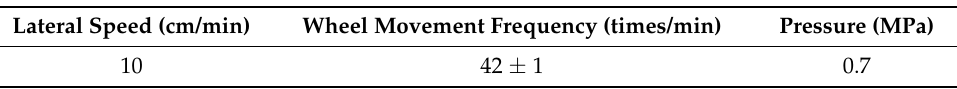
Table 9. Operating parameters of abrasion